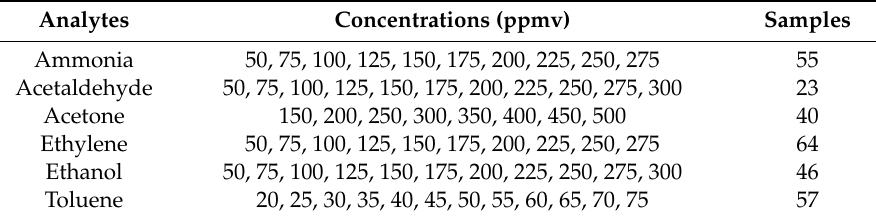
Table 1. Dataset details with analytes, their concentrations and number of